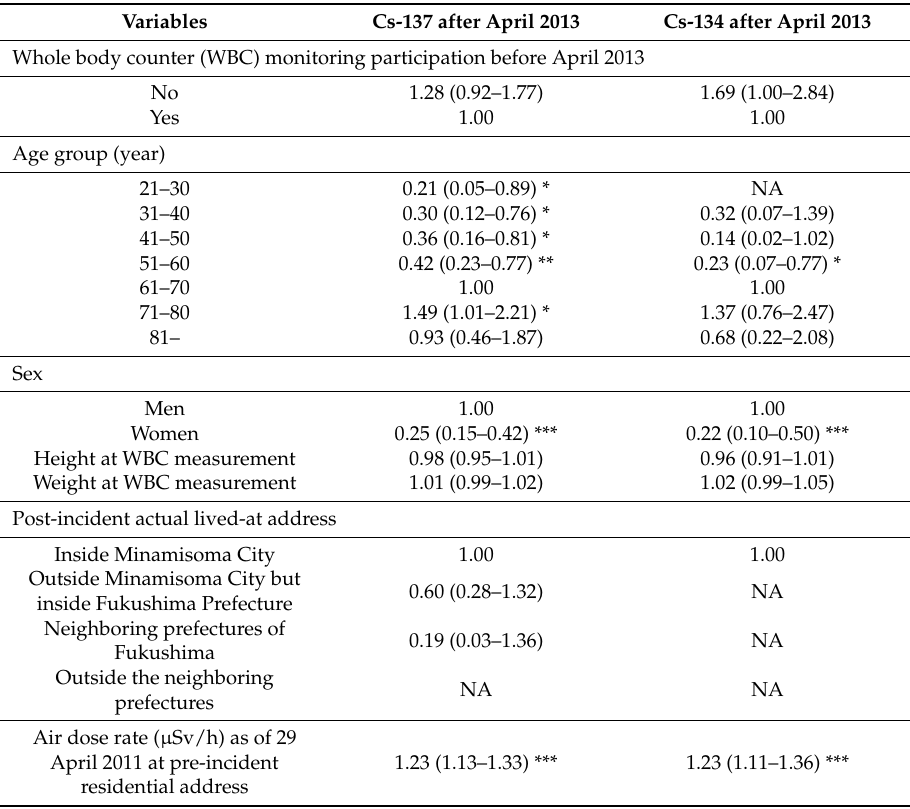
Table 3. Regression models to examine the potential differences in odds for detection of Cs-137 and Cs-134 after April 2013 between those who participated in the WBC monitoring and those who did not before April.